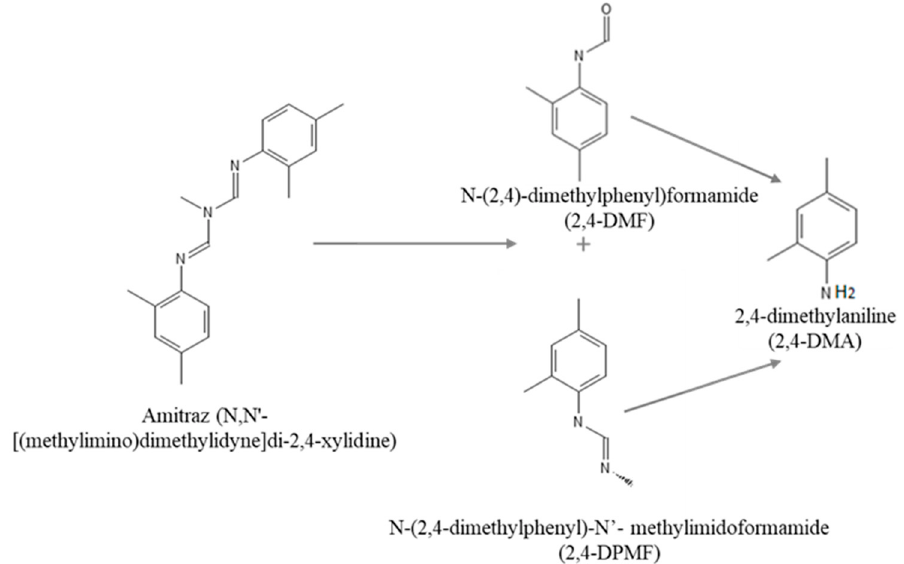
Figure 1. Hydrolysis pathway of amitraz (under acidic conditions) to its main compounds (DMF and DPMF), which can by rapidly hydrolyzed to 2,4-DMA under alkaline conditions.